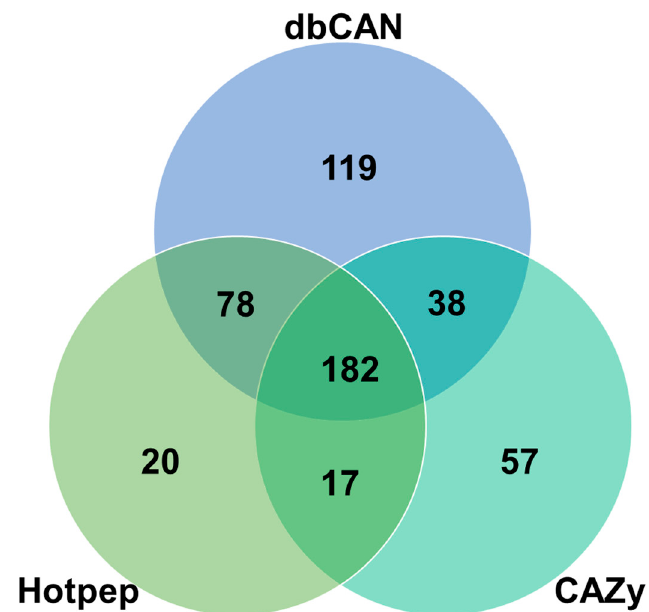
Figure 2. Identification and annotation of carbohydrate-active enzyme genes in the F. rossica genome based on three different databases including the HMMER (dbCAN carbohydrate-active enzymes domain HMM database), DIAMOND (CAZy database), and Hotpep (short conserved motifs in the (PRR library database) [32].